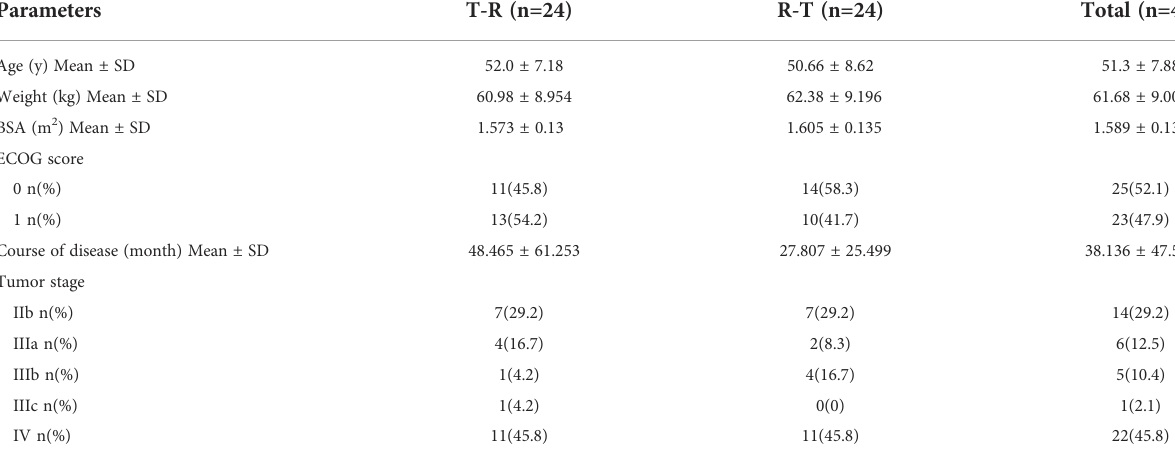
TABLE 1 The Demographic Characteristics.